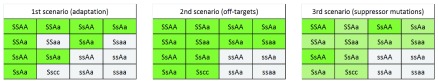
Theoretical genotype and phenotype segregation in F2 progeny of the
abp1 knock-out x knock-down cross.Expected genotype and phenotype segregation ratios for three possible scenarios are shown. S/s = ethanol-inducible cassette positive/negative, A/a = wild-type
ABP1/
abp1 knock-out. Genotypes manifesting wild-type phenotype are shown on white background, KD phenotype on green background, genotypes that might exhibit both WT and KD phenotypes are on pale green background.